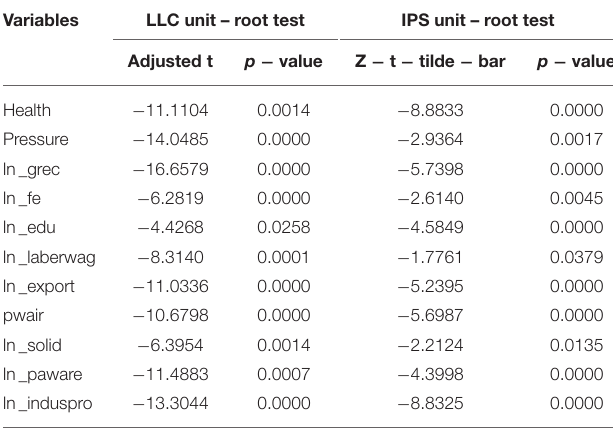
TABLE 2 | Panel unit root tests.